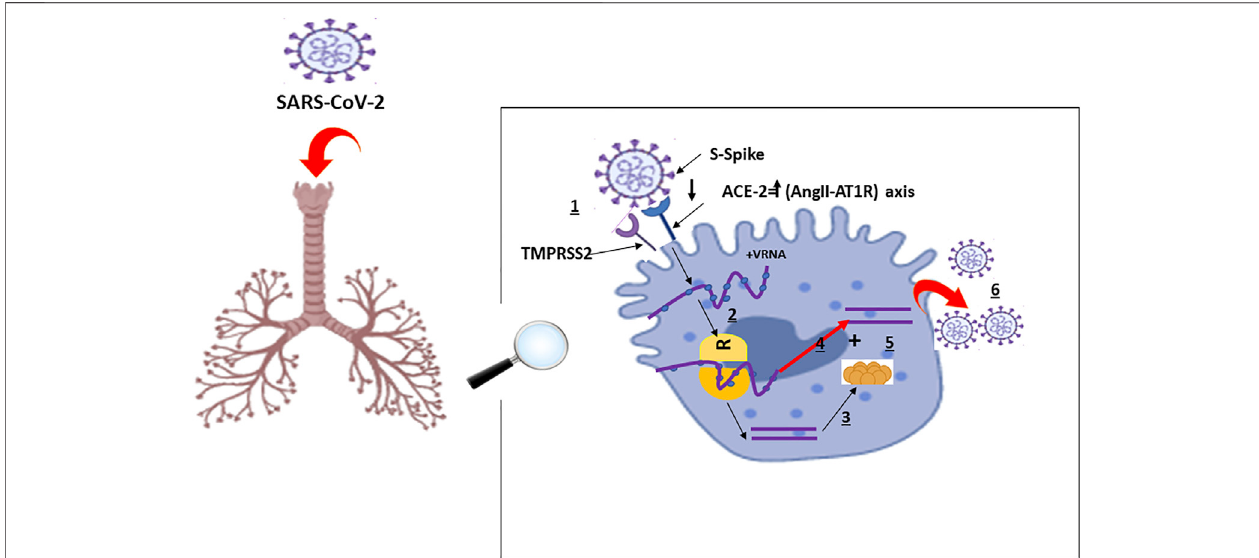
FIGURE 1 | Schematic Representation of Physiological Host Response to SARS-CoV-2 Infection with A and B representing the disease severity and related events:A:Viral entryandearlyinfection (Proptosisinduction): (WorldHealthOrganization,2020):SARS-CoV-2viralinfection ofalveolar epithelialcells viasurfacebinding ofspike(S)proteintoangiotensinconvertingenzyme2facilitatedbytransmembraneserineprotease2: SARS-CoV-2: SevereAcuteRespiratorySyndromeCoronavirus 2; TMPRSS2: S protein priming; ACE-2 : Angiotensin-Converting Enzyme 2; AngII-AT1R: AngII-angiotensin type 1 receptor; VRNA : Viral Ribonucleic Acid; R